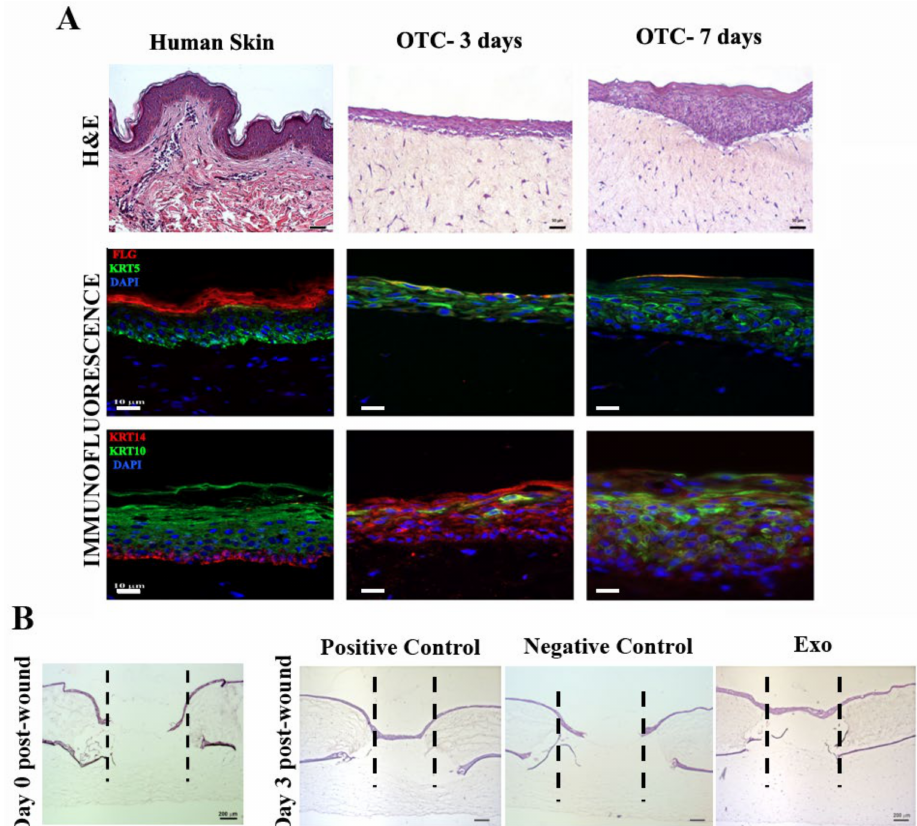
Figure 8. Exosomes support wound healing on a human skin organotypic model. ( A ) Histological (hematoxylin and eosin staining) and immunofluorescence images showing the skin-like structure of the organotypic culture versus human adult skin tissue (left). Note the expression of keratinocytes markers fillagrin (FLG) and keratins (KRT) 5, 10, and 14, similar to the skin control. ( B ) Hematoxylin and eosin staining showing the healing of the skin organotypic cultures: left, image taken immediately after performing the punch wound (day 0 post-wound); right, after 3 days for the samples incubated with complete medium (positive control), basal medium (negative control), and exosomes